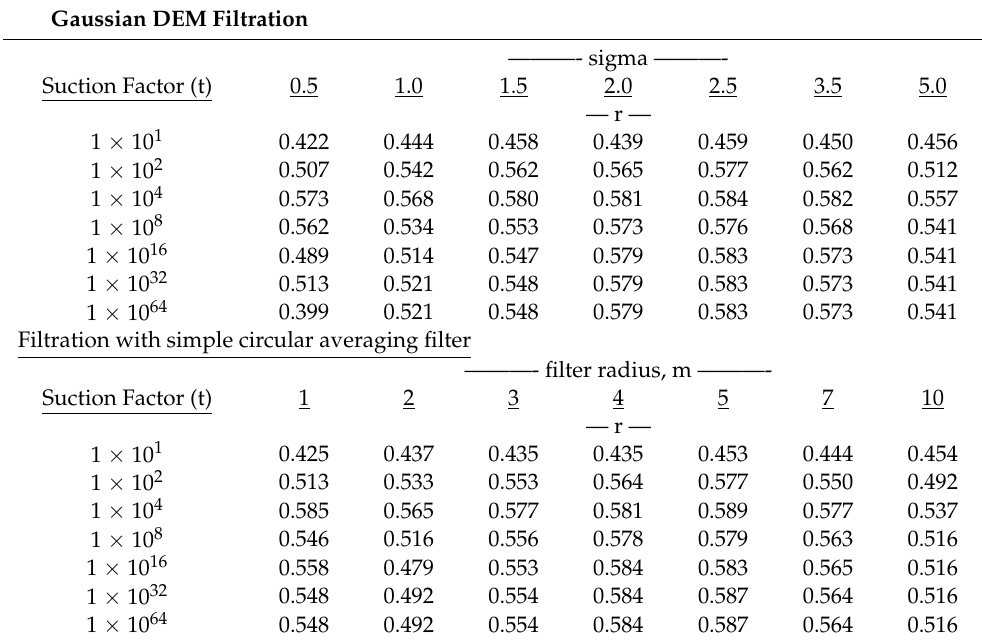
Figure 10. Influence of the suction factor (t) on the performance of the SAGA wetness index at DEM generalized to different grid cell resolutions (w). Pearson correlation between observed grand mean moisture and index value is indicated by “r”. Table 2. Pearson correlation between grand mean VWC for the measurement period 2017–2021 and SAGA Wetness Index with increasing t values after DEM filtration.